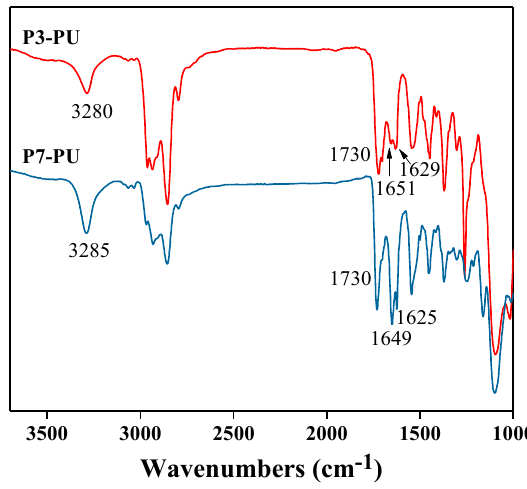
Figure 4. FTIR spectra of P3-PU and P7-PU .